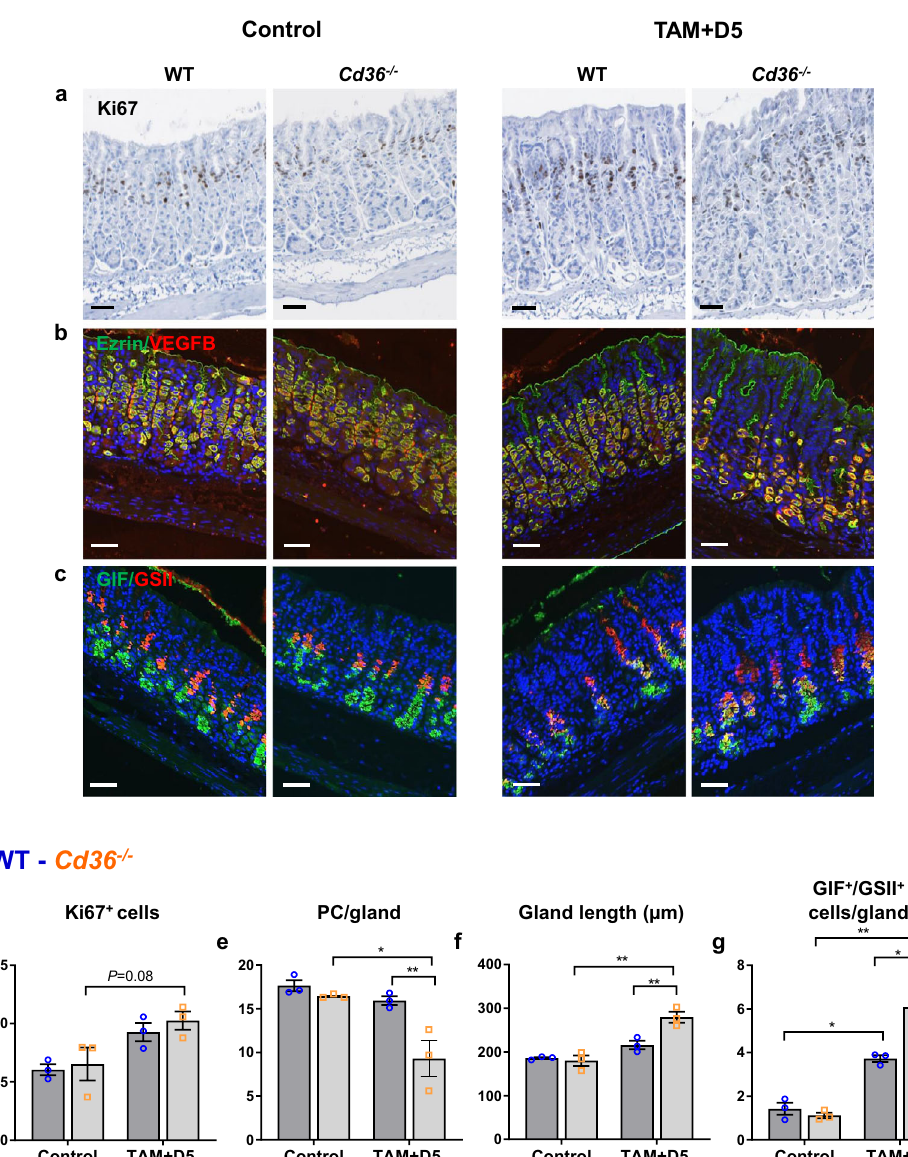
Fig. 4 CD36 is required for parietal cell (PC) renewal and recovery during gastric injury. a – c Representative histology and immunohistochemistry of wildtype (WT) and Cd36 − / − mice that were either untreated (control), or injected with TAM for 3 days followed by 5 days of recovery (TAM + D5); a proliferation marker ki67; b vascular endothelial growth factor B (VEGFB), red; ezrin, green; c GIF, green; GSII, red. Scale bar: 50 µ m. Quanti fi cation of d ki67 + cells and e parietal cells per gastric unit, f gland length, and g GIF/GSII + cells per gastric unit (yellow). Signi fi cance was calculated using a two-way ANOVA followed by post hoc tests by Sidak multiple comparisons. * P < 0.05, ** P < 0.01. Data are means ± SEM, n = 3 controls (Supplementary Fig. 5a – d). These data show that while global Cd36 de fi ciency results in dysfunctional progenitors and reduced PC renewal, deletion of Cd36 in mature PC is not, by itself, suf fi cient to cause the corpus abnormalities and delayed injury recovery seen in Cd36 − / − stomachs. Cd36 deletion in endothelial cells reduces stomach FA uptake and recapitulates major gastric abnormalities of Cd36 -/- mice . Recent fi ndings documented a primary role of endothelial cell CD36 in FA uptake by the heart, muscle, and brown adipose tissue 46 . As in these tissues, CD36 in the stomach is most robustly expressed on ECs in the corpus. We examined if EC- Cd36 − / − mice can recapitulate the morphologic and metabolic alterations and the delayed PC recovery observed in Cd36 − / − stomachs.